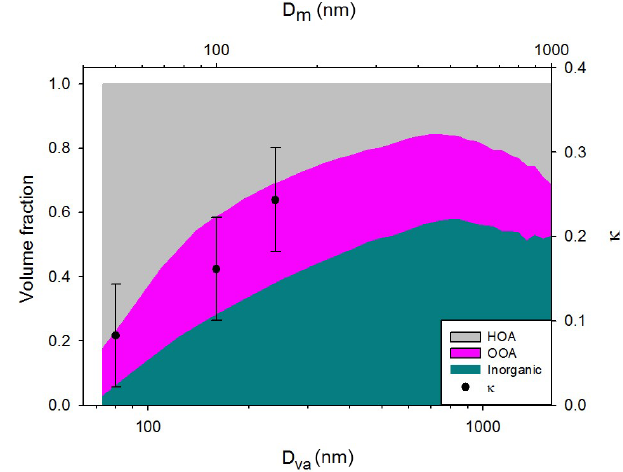
Figure 5. Campaign-averaged size distributions of reconstructed HOA (gray) and OOA (pink).